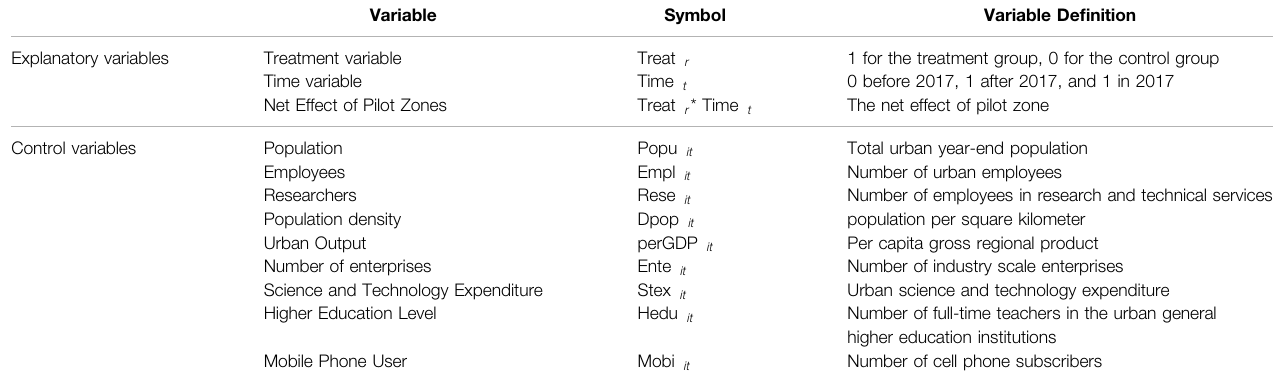
TABLE 4 | De fi nition and description of explanatory and control variables.